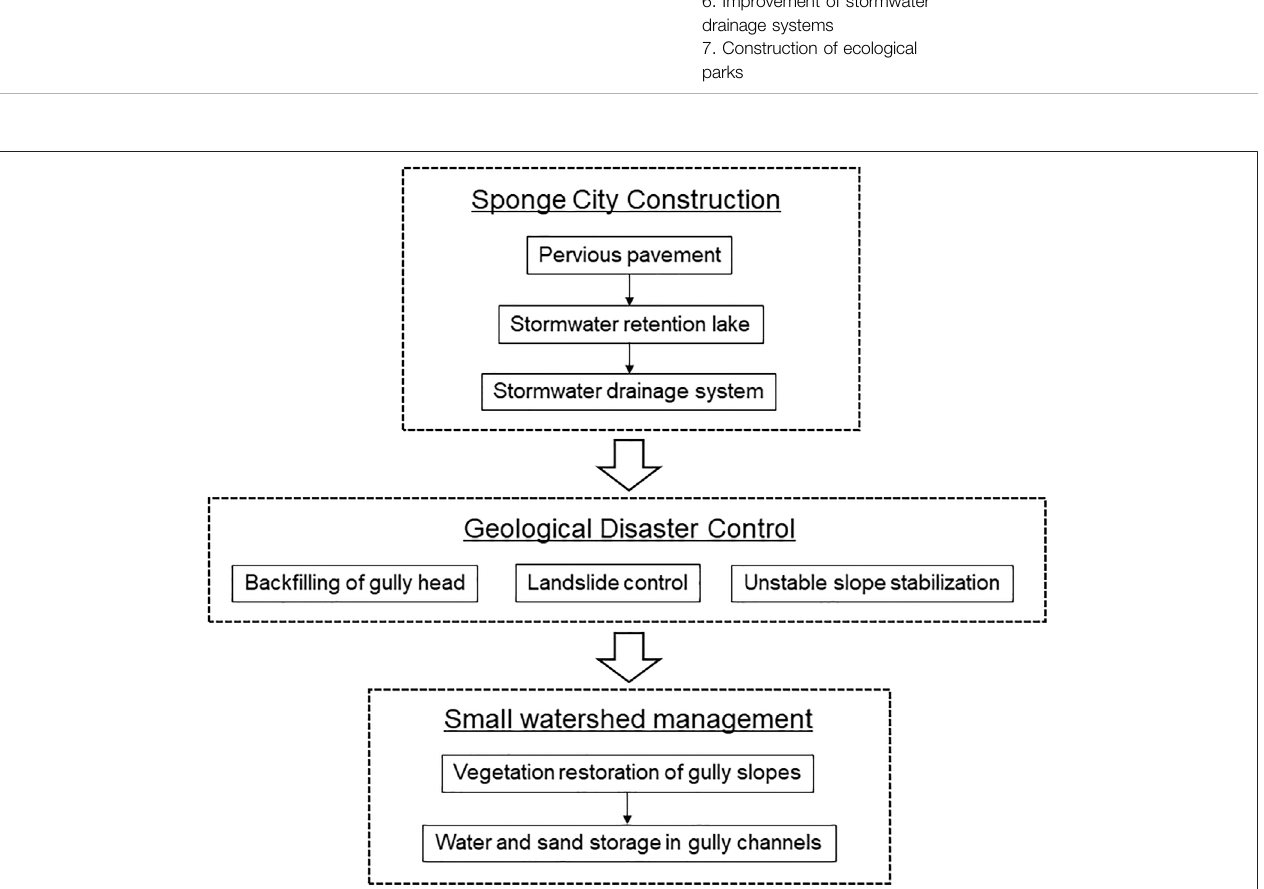
FIGURE 4 | The framework of the GSHP